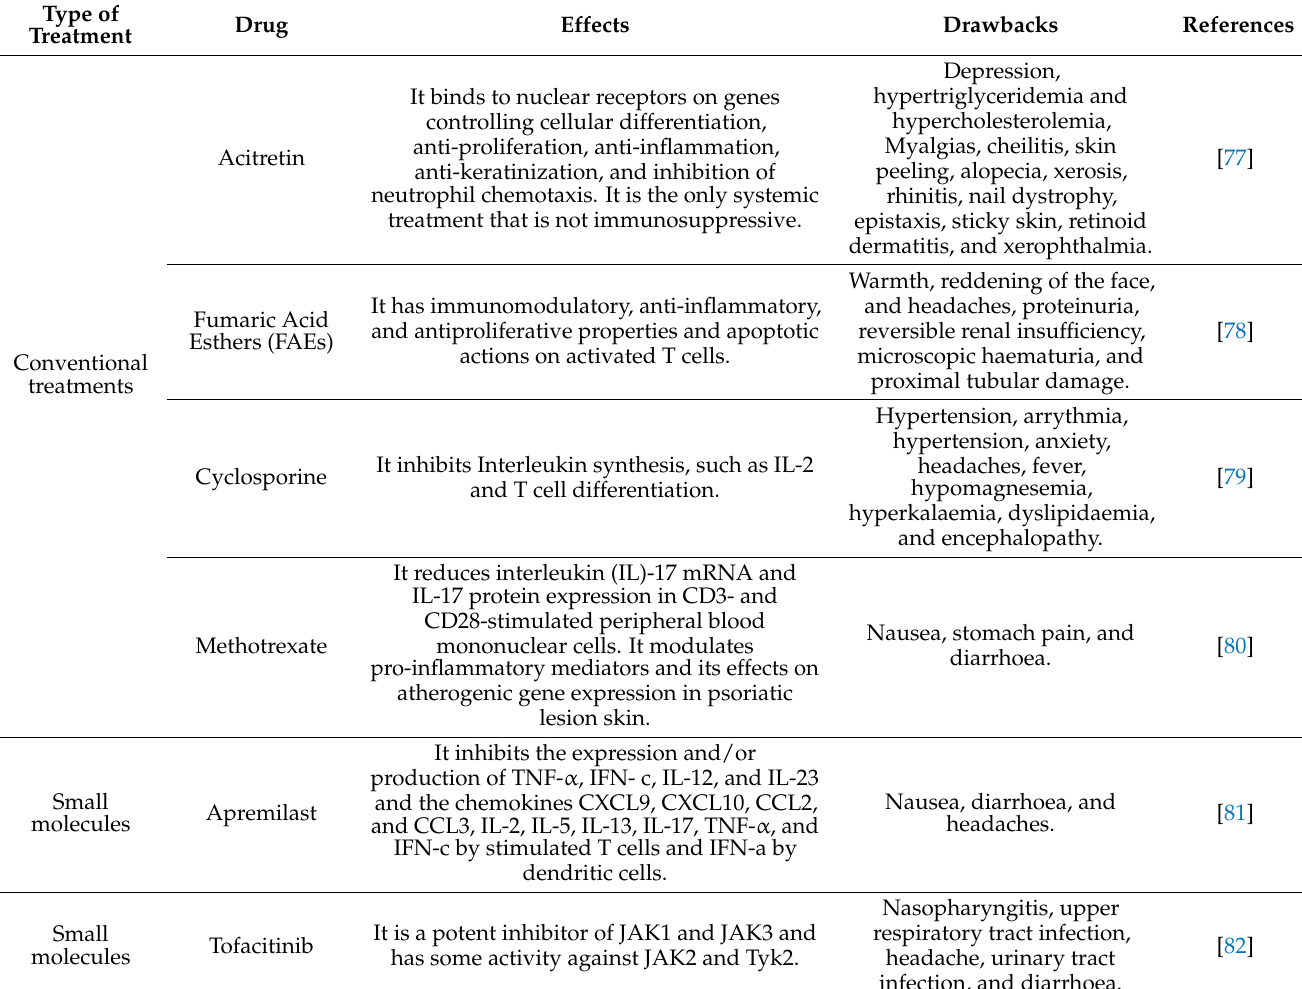
Table 2. Accepted systemic